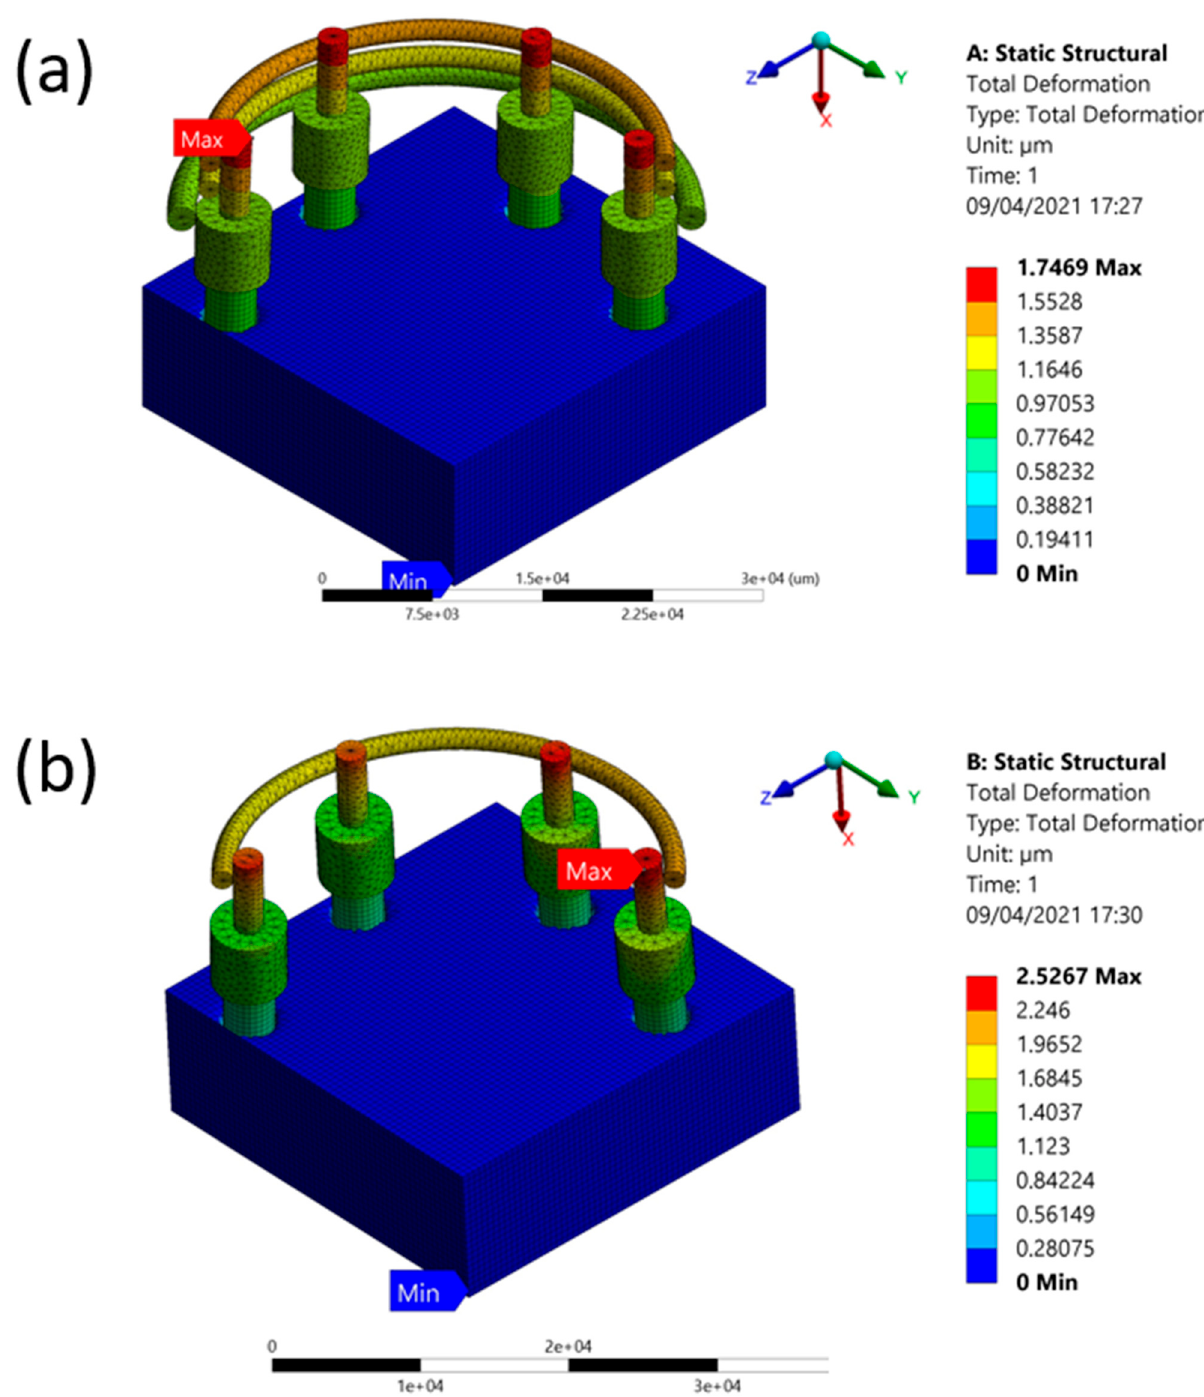
Figure 1. ( a ) Deformation when using three fences. ( b ) Deformation when using one fence.